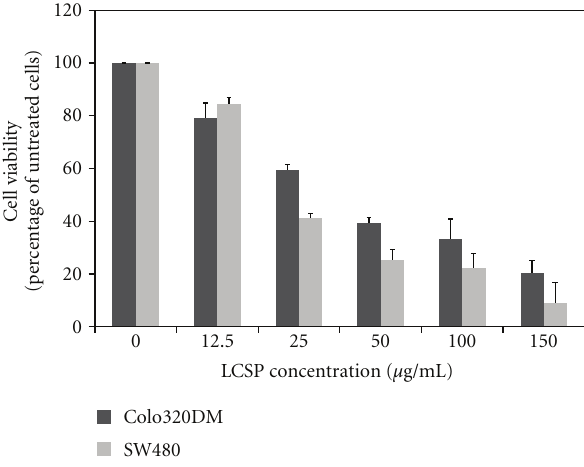
Figure 1: The dose-dependent response of CRC cells to LCSP. Colo320DM and SW480 cells were treated with increasing concen- trations of LCSP as indicated and then incubated at 37 ◦ C for 24 h. Viable cells were trypsinized, stained with trypan blue, and counted under a microscope. Cell viability was expressed as a percentage of untreated cells. Data are the average of three independent experi- ments and are expressed as means ±